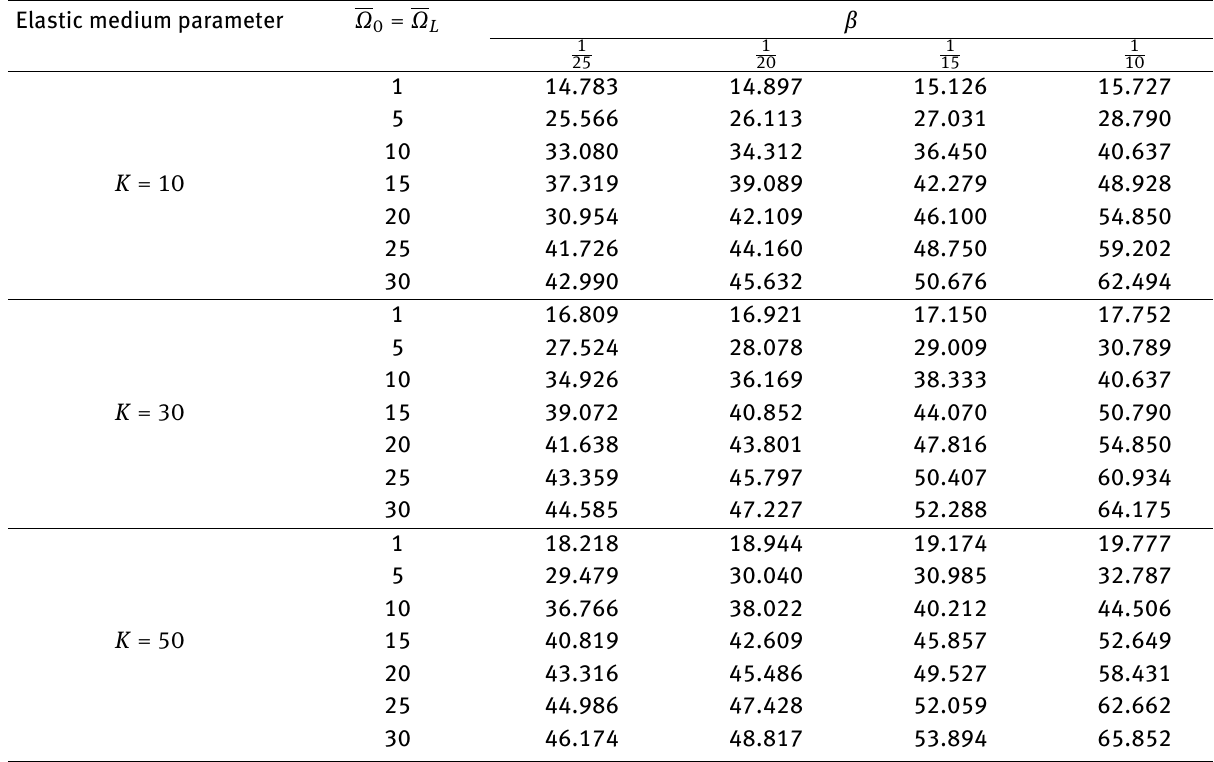
Table 4: The critical buckling loads of restrained microbar under an elastic matrix Elastic medium parameter